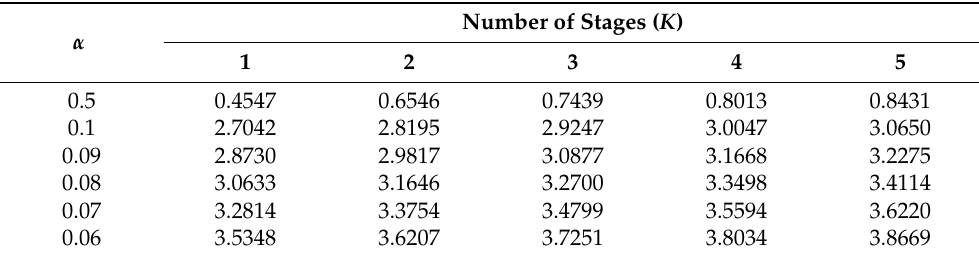
Table 2. Corrected O’Brien–Fleming critical